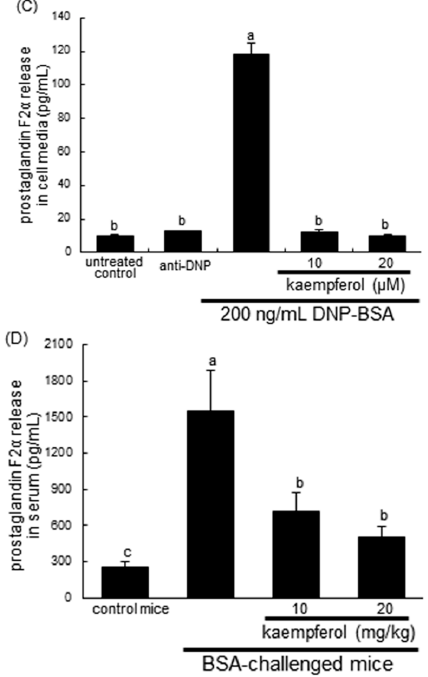
Figure 4. Production of prostaglandin D2 (PGD2) and prostaglandin F2 α (PGF2 α ) in sensitized RBL-2H3 cells ( A ) and BALB/c mice ( B ). Rat basophilic leukemia RBL-2H3 cells were sensitized by the addition of 0.5 μ g/mL anti-2,4-dinitrophenol (anti-DNP) and stimulated with 200 ng/mL of DNP-bovine serum albumin (BSA) in the absence and presence of 10–20 μ M kaempferol. For in vivo experiments, BSA-sensitized mice on days 0 and 14 were challenged with 5% BSA on days 28, 29, and 30. Mast cell formation of PGD2 formation ( A ); mouse lung tissues level of PGD2 ( B ); mast cell release of PDF2 α ( C ) and mouse serum level of PGF2 α ( D ) were measured by using ELISA kits. Values in bar graphs not sharing a common letter refer to significantly different at p <